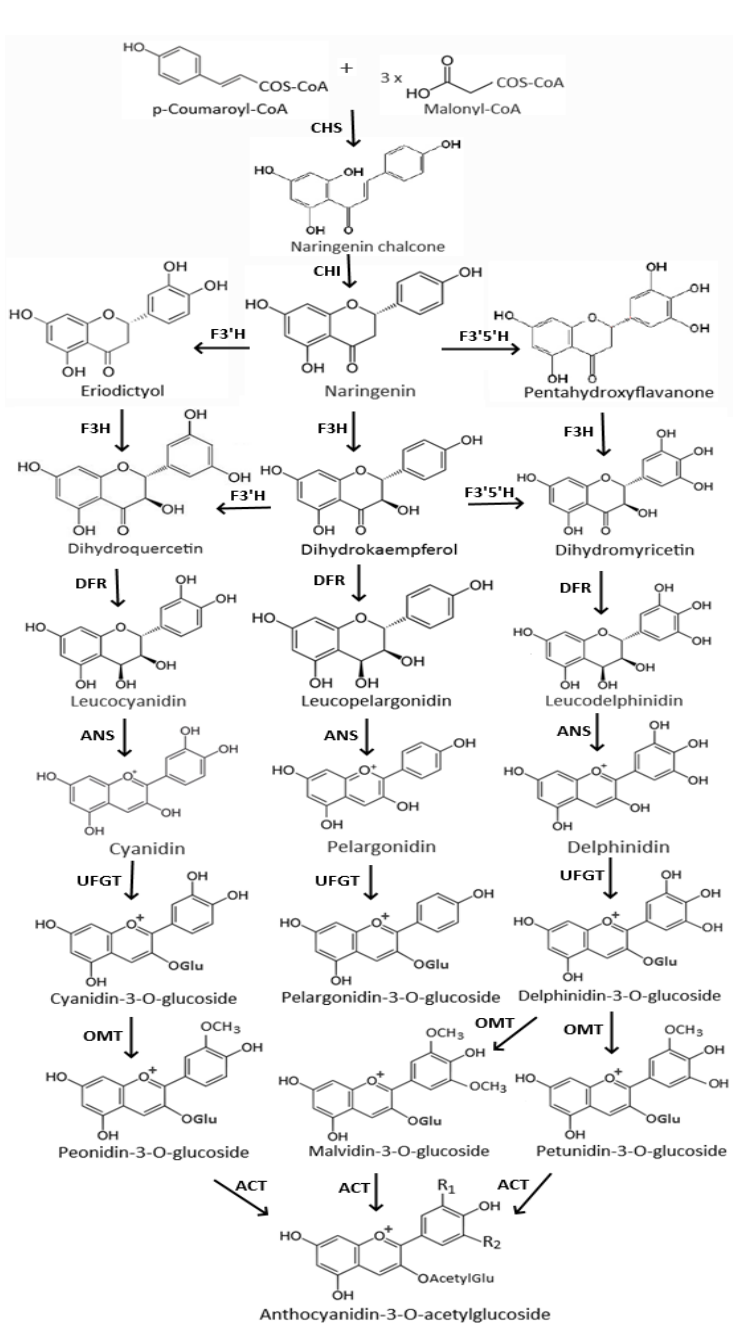
Figure 1. Biosynthesis pathway for anthocyanin production in plants. CHS, chalcone synthase; CHI, chalcone isomerase; F3H, flavanone 3-hydroxylase; F3 (cid:48) H, flavonoid 3 (cid:48) -hydroxylase; F3 (cid:48) 5 (cid:48) H,